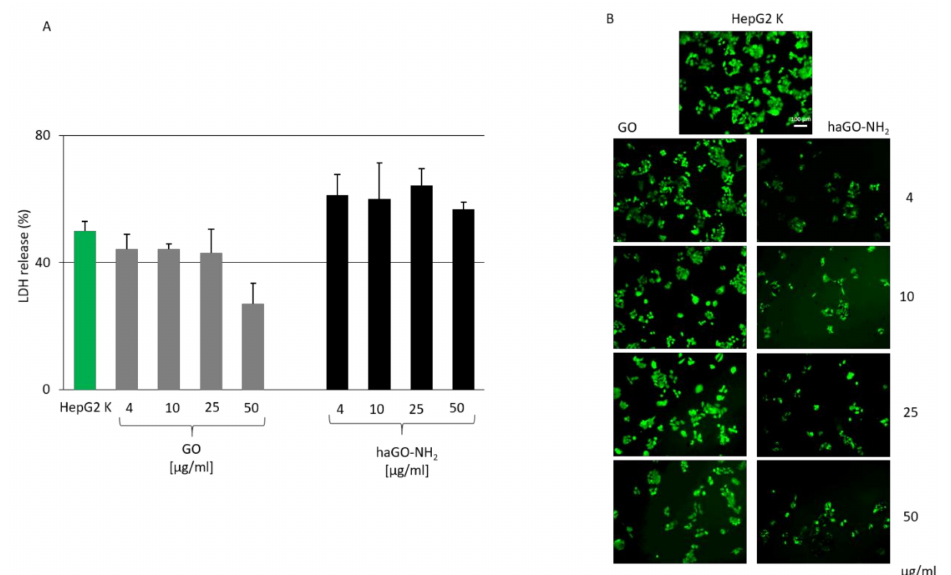
Figure 4. Membrane integrity of HepG2 cells treated for 24 h with pristine and aminated GO. ( A ) Percentage of LDH release fromHepG2 cells after 24 h of incubation in the presenceof di ff erent